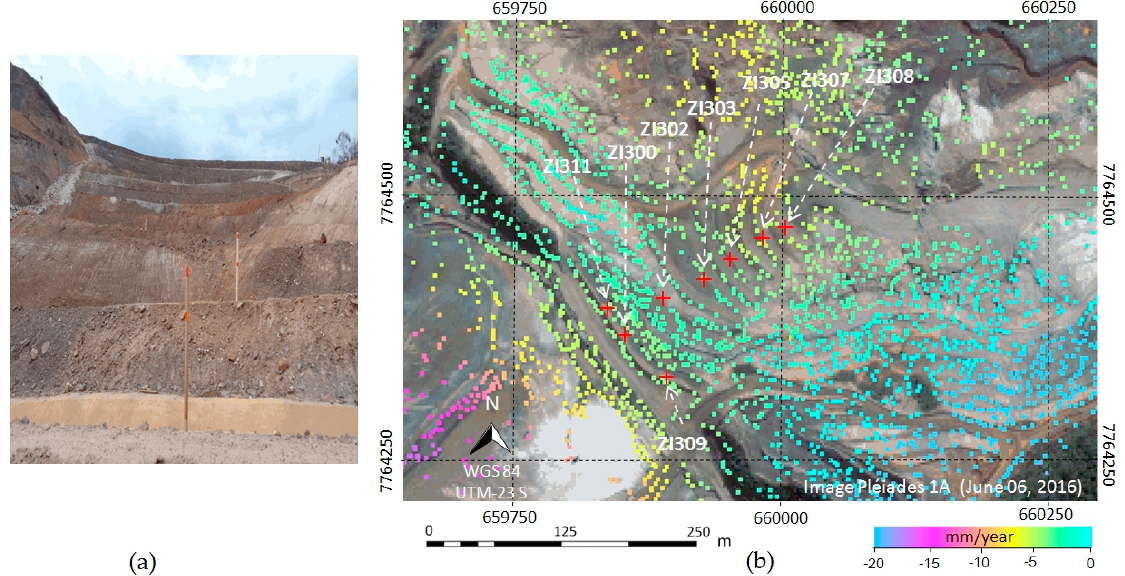
Figure 16. Field picture of the wall of the Selinha dike ( a ) and the ground displacement map derived from PSI analysis showing the positions of the prisms ( b ).